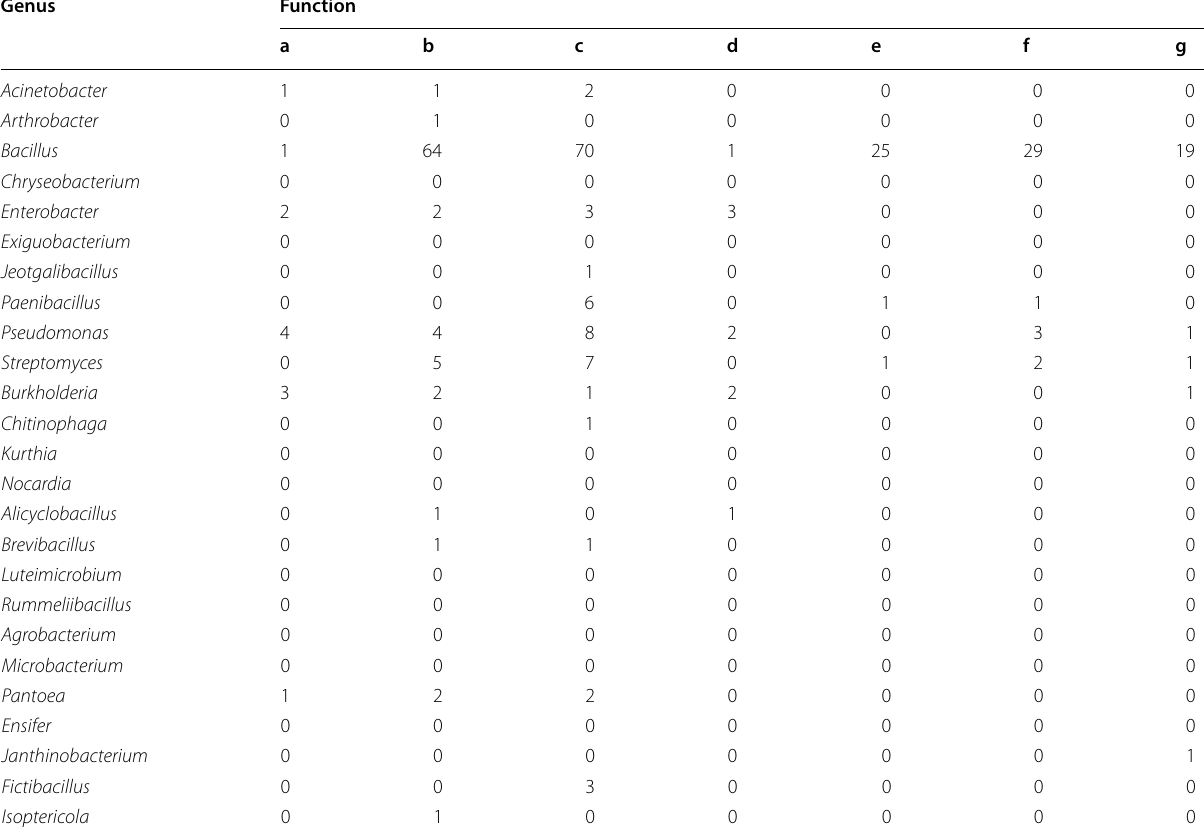
Table 4 Number of bacterial isolates from different genera and functional